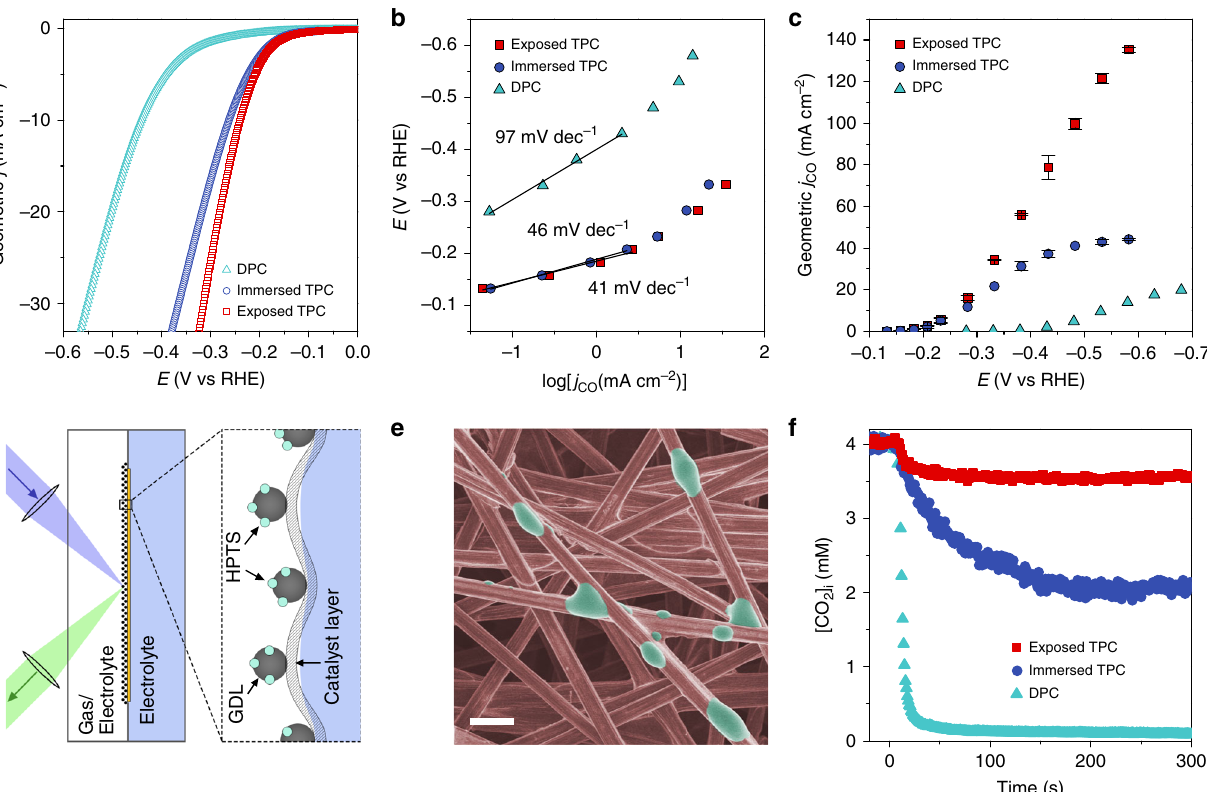
Fig. 4 Electrochemical CO 2 RR over different interfacial structures. a LSV of Au/C-P-0.5 electrodes in 1 M KOH for the TPC systems and in CO 2 - saturated 1 M KHCO 3 for the DPC system. b CO production Tafel plot of Au/C-P-0.5 electrodes over exposed TPC, immersed TPC and DPC systems. c Geometric j CO of Au/C-P-0.5 over the three systems versus applied cathodic potentials. Error bars represent the standard deviation of three independent experiments. d Schematic illustration of in situ fl uorescence electrochemical spectroscopy measurements. e Colour-modi fi ed SEM image of HPTS-labelled gas diffusion layer. Bright green is the CO 2 -sensitive HPTS gel immobilized on the surface of carbon fi bres, scale bar: 20 μ m. f Time-dependent [CO 2 ] i during CO 2 RR at 50 mA cm − 2 . Time = 0 s represents the start of electrolysis. Source data are provided as a Source data fi